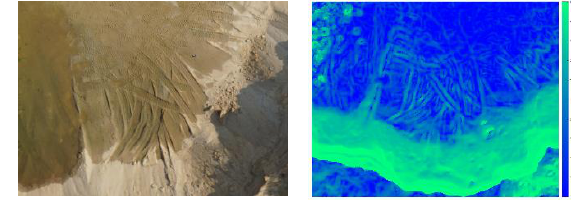
Figure 14. Tire tracks and the correspondent part of the slope map Figure 16. 3D distances between CKP2 set and the scenario 1 Our developed toolbox can perform different types of visualization. Figure 16 shows the 3D distances between the CKP2 set (118 points on the upper flat area) and scenario 1.